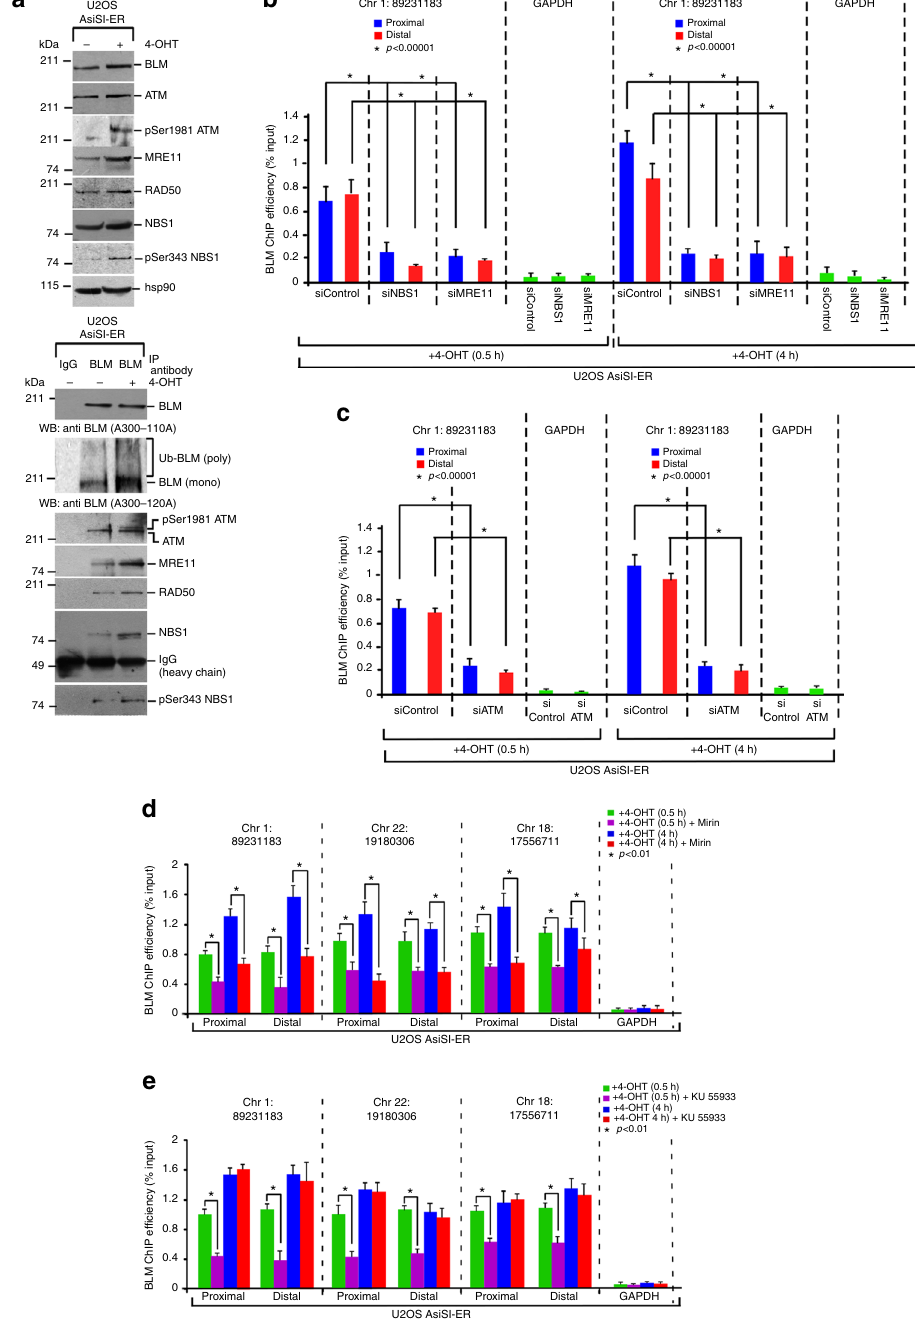
Fig. 2 Recruitment of BLM at the DSBs. a BLM co-immuoprecipitates with MRN complex and ATM after DSB generation. (Top) Extracts were made from U2OS – AsiSI – ER cells (±4-OHT, 4 h). Lysates were probed with antibodies against BLM (only A300-110A), ATM, pSer1981 ATM, MRE11, RAD50, NBS1, pSer343 NBS1, hsp90. (Bottom) Immunoprecipitations (±4-OHT, 4 h) were carried out with anti-BLM antibody or the corresponding IgG and the immunoprecipitates were probed with the above-mentioned antibodies. b , c Recruitment of BLM to the DSBs is dependent on the presence of NBS1, MRE11, and ATM in both 0.5 h and 4 h post induction of DSBs. ChIP was carried out using anti-BLM antibody on chromatin obtained from U2OS – AsiSI – ER cells grown in the presence of 4-OHT for either 0.5 or 4 h after transfection with either b Control siRNA or NBS1 siRNA or MRE11 siRNA, or c control siRNA or ATM siRNA. BLM recruitment to the indicated AsiSI-induced DSB or GAPDH loci were determined by ChIP-qPCR after either 0.5 or 4 h of 4-OHT treatment. d Recruitment of BLM to DSBs partially depends on MRE11 exonuclease activity. ChIP was carried out using anti-BLM antibody on chromatin obtained from U2OS – AsiSI – ER cells grown in presence of 4-OHT for either 0.5 or 4 h. In both the time points, the cells were grown either in + 4-OHT or in + 4-OHT + Mirin conditions. BLM recruitment to the indicated AsiSI-induced DSBs or GAPDH loci were determined by ChIP-qPCR. e Recruitment of BLM to DSBs depends on ATM kinase activity only in the early phase. ChIP was carried out using anti-BLM antibody on chromatin obtained from U2OS – AsiSI- ER cells grown in the presence of 4-OHT for either 0.5 or 4 h. In both the two time points, the cells were grown in + 4-OHT or + 4-OHT + KU 55933 conditions. BLM recruitment to the indicated AsiSI-induced DSBs or GAPDH loci were determined by ChIP-qPCR. For all ChIP-qPCR analyses, the depicted values (mean ± standard deviation) were obtained from four independent experiments. Data were analyzed by unpaired two-tailed Student ’ s t